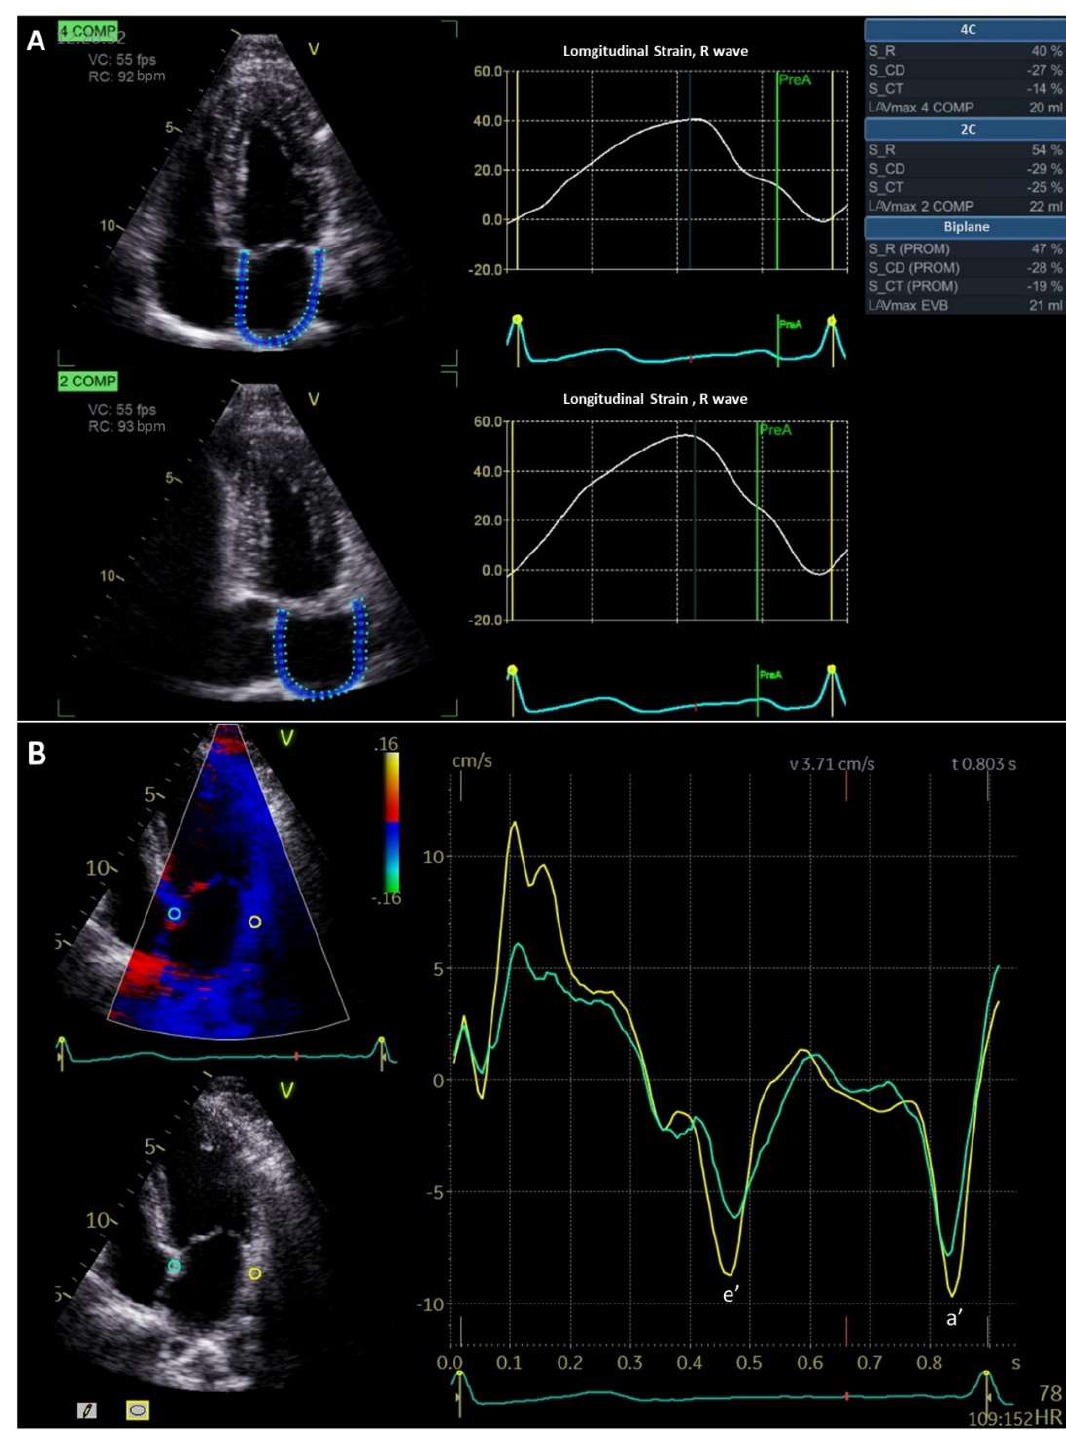
Figure 4. Atrial function evaluated by speckle tracking ( A ) and tissue Doppler imaging ( B ). Left atrial strain curves ( A ) with R wave as time reference, showing the 3 phases of the atrial function measured in apical four and two chamber views: reservoir longitudinal strain (47%) is the peak positive value, conduit longitudinal strain (−28%) is the measurement during early diastole and contractile longitudinal strain (−19%) is the value during end-diastole. Tissue Doppler imaging in the apical four chamber view to assess regional LA function ( B ). The samples are placed in atrial (green) and in the lateral wall (yellow). Peak diastolic velocities are assessed. Early diastolic filling is indicated by e’ and end-diastolic filling with a’.